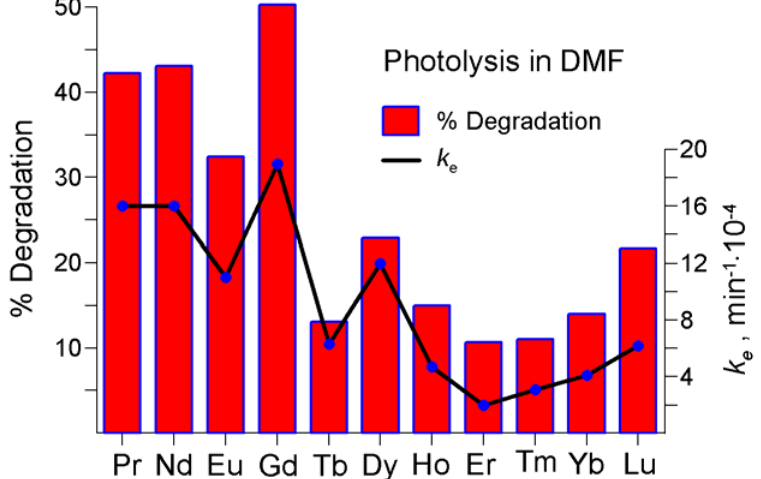
Figure 12. Degradation degree (%) and effective reaction rate constants, k the photolysis carried out in DMF (for details see Table 4).